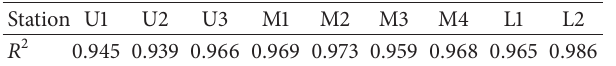
Table 1: Coefficient of determination of monthly 𝐸 nine meteorological